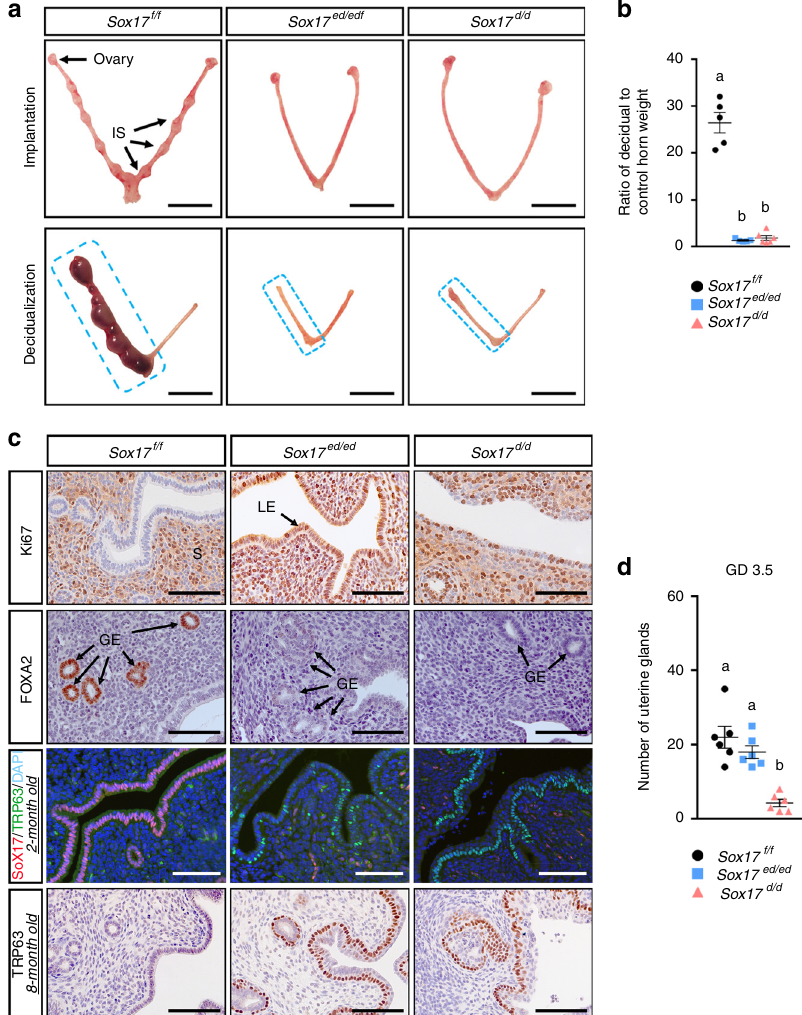
Fig. 1 Phenotype of conditional deletion of Sox17 in the adult mouse uterus. a Embryo implantation sites (top panel) and arti fi cial deciduoma formation (bottom panel) in Sox17 f/f (control), Sox17 ed/ed ( Ltf iCre Sox17 f/f ), and Sox17 d/d ( Pgr Cre Sox17 f/f ) female mice ( n = 5). Scale bars: 10 mm. IS, implantation site. b Ratio of decidual to control horn weight in Sox17 f/f (black dots), Sox17 ed/ed (blue squares), and Sox17 d/d (pink triangles) mice ( n = 5). c Immunohistochemical staining of Ki67 (row 1), FOXA2 (row 2), TRP63 (row 3) in the 2-month old uteri of Sox17 f/f , Sox17 ed/ed , and Sox17 d/d female mice at GD 3.5 ( n = 3). Row 4 is TRP63 staining in the 8-month old uteri ( n = 3). Scale bars: 100 µ m. S, stroma; LE, luminal epithelium; GE, glandular epithelium. d Number of endometrial glands in the 2-month old uteri from Sox17 f/f (black dots), Sox17 ed/ed (blue squares), and Sox17 d/d (pink triangles) mice at GD 3.5 ( n = 3 mice × 2 sections per mice = 6). Different superscript letters denote signi fi cant ( P < 0.05, ANOVA with Tukey ’ s post hoc test) differences. Data are presented as means ±